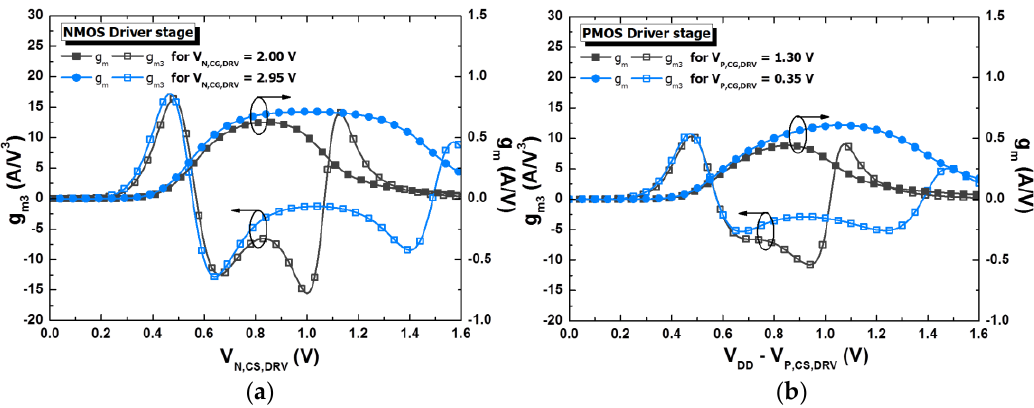
Figure 7. Simulated g m and g m3 of the driver stage (V DD = 3.3 V): ( a ) typical NMOS driver stage, ( b ) proposed PMOS driver stage.